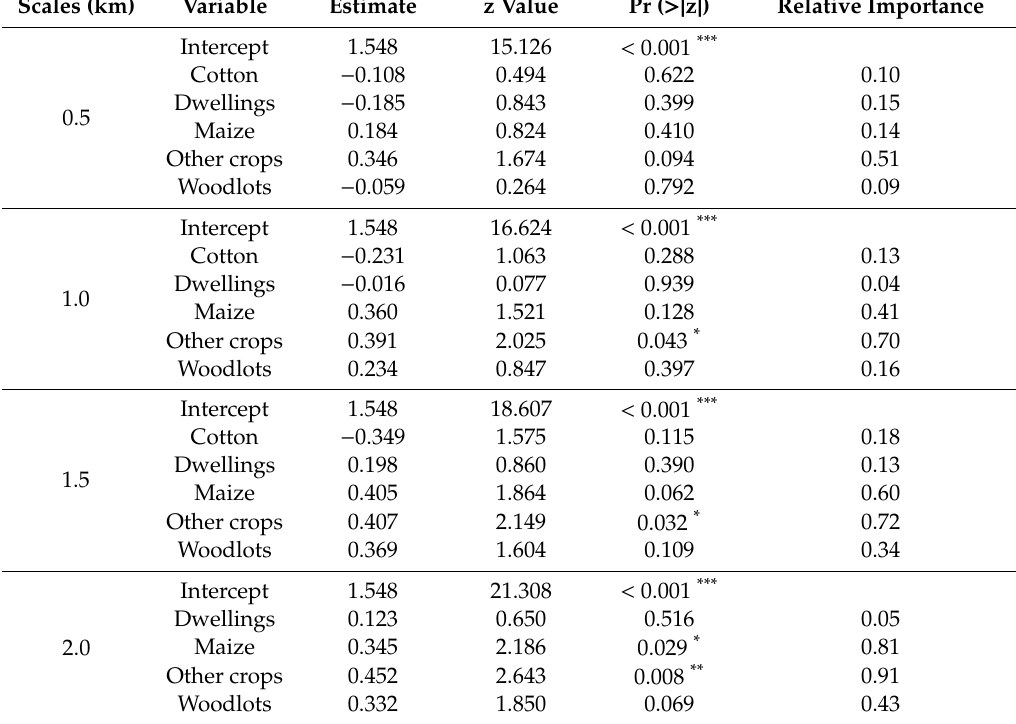
Table 4. Results of model averaging procedure to estimate landscape e ff ects on abundance of